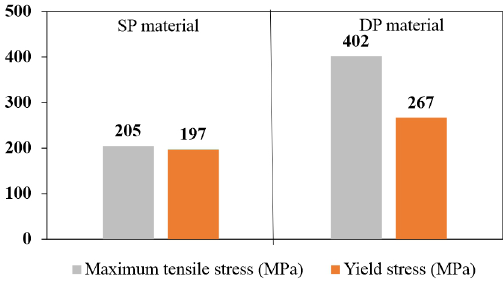
Figure 2. Maximum tensile stress and yield stress for the SP and DP